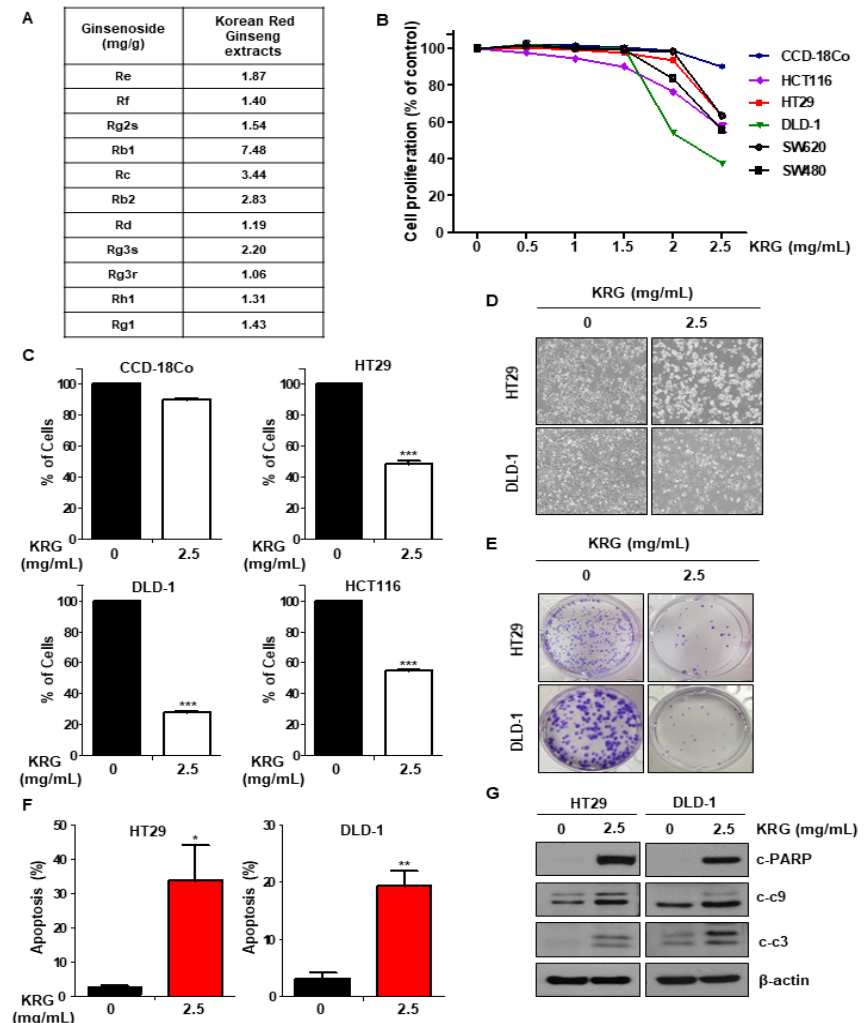
Figure 1. KRG extract reduces viability and induces apoptosis of human CRC cells. ( A ) Ginsenoside content (mg/g) of KRG extract. ( B ) The cell proliferation of normal colon cell line (CCD-18Co) and various CRC was detected by the MTT assay after treatment with 0–2.5 mg/mL KRG extract. ( C ) Cell proliferation of CRC and CCD-18Co cell lines was assessed by trypan blue staining after KRG extract treatment. Cells were incubated in the absence or presence of 2.5 mg/mL KRG extract for 48 h. ( D ) HT29 and DLD-1 cells were treated with 2.5 mg/mL KRG extract for 48 h, and the morphology of the cells was evaluated by light microscopy. Scale bar: 100 μ m. ( E ) HT29 and DLD-1 cells were treated with 2.5 mg/mL KRG extract. After 2 weeks, the cells were stained with crystal violet and were photographed using a digital camera. ( F ) Levels of cleaved caspase-3, cleaved caspase-9, and cleaved PARP were detected by western blotting. ( G ) HT29 and DLD-1 cells were treated with 2.5 mg/mL KRG extract for 48h, stained with annexin V/PI, and assessed using FACS analysis.The data are shown as the mean of many repeated independent experiments. *** p < 0.001, ** p < 0.01, * p < 0.05. KRG: Korean Red Ginseng. CRC: colorectal cancer. FACS: fluorescence-activated cell sorting.